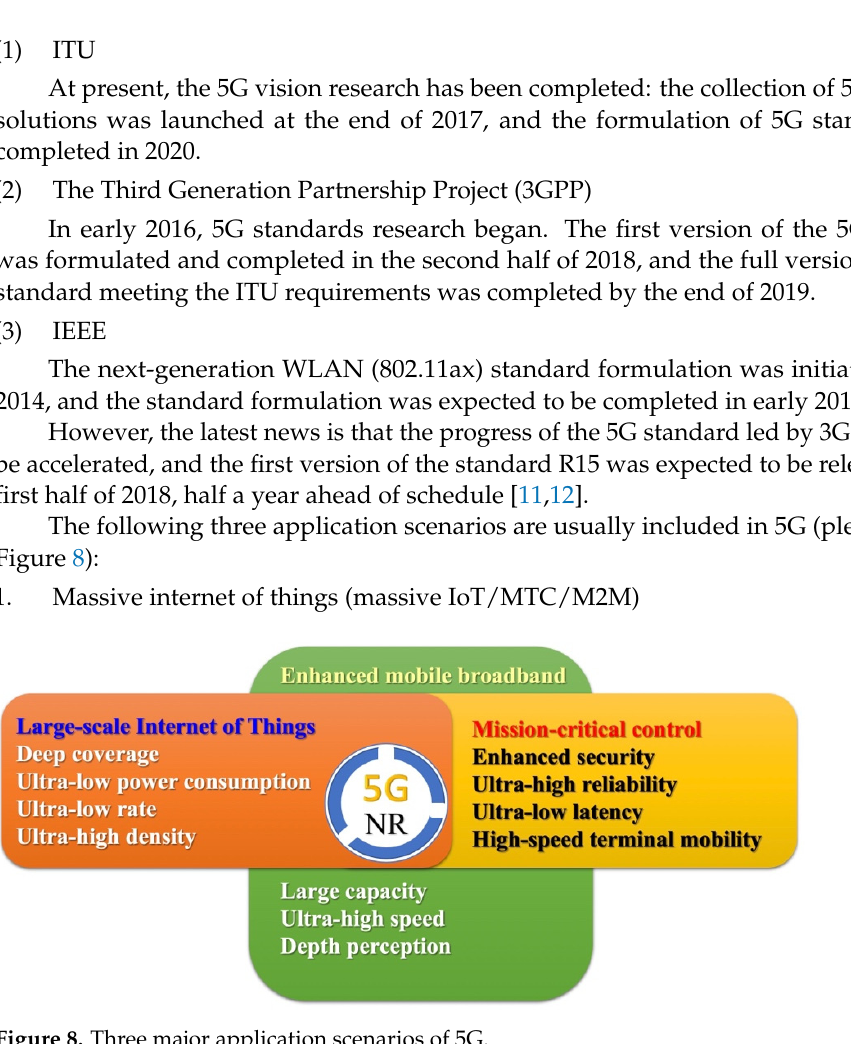
Figure 8. Three major application scenarios of 5G.